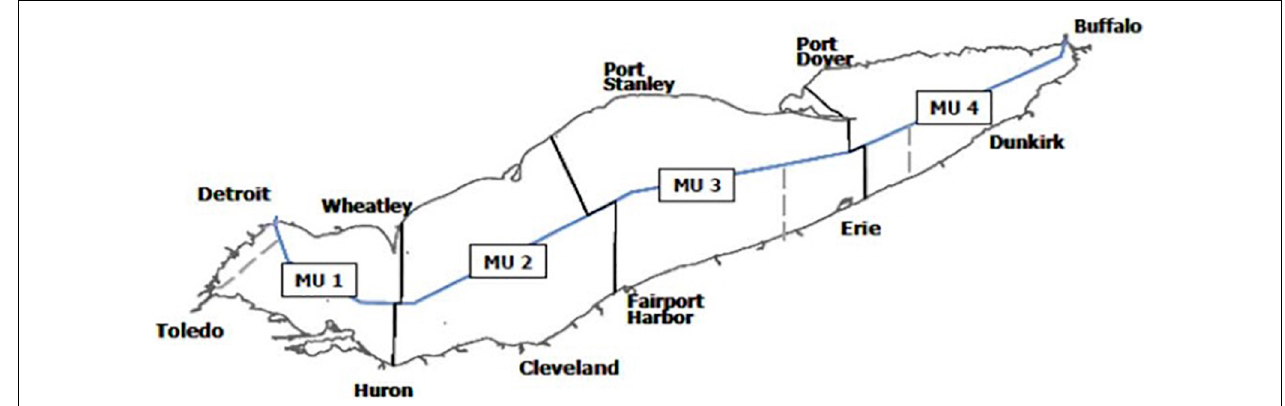
FIGURE 1 | Yellow Perch management units (MUs) in Lake Erie. Figure from Lake Erie Yellow Perch Task force annual